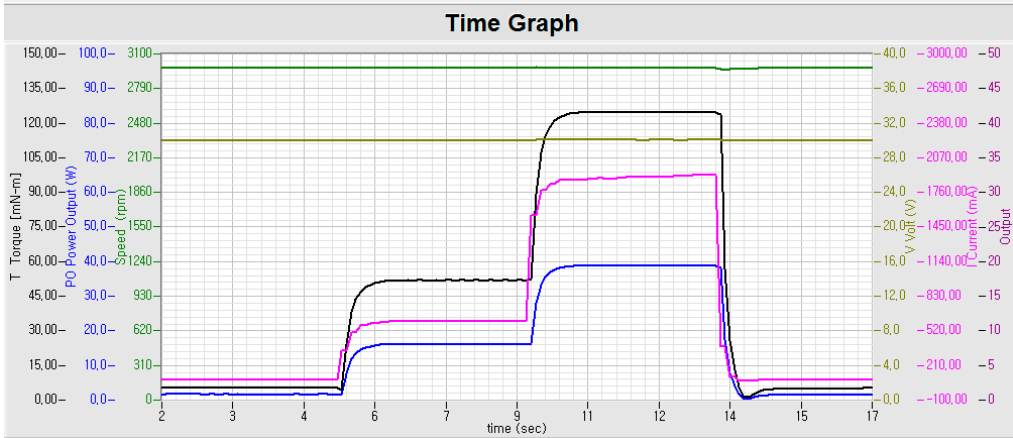
Figure 20. Output waveform of the motor performance tester.